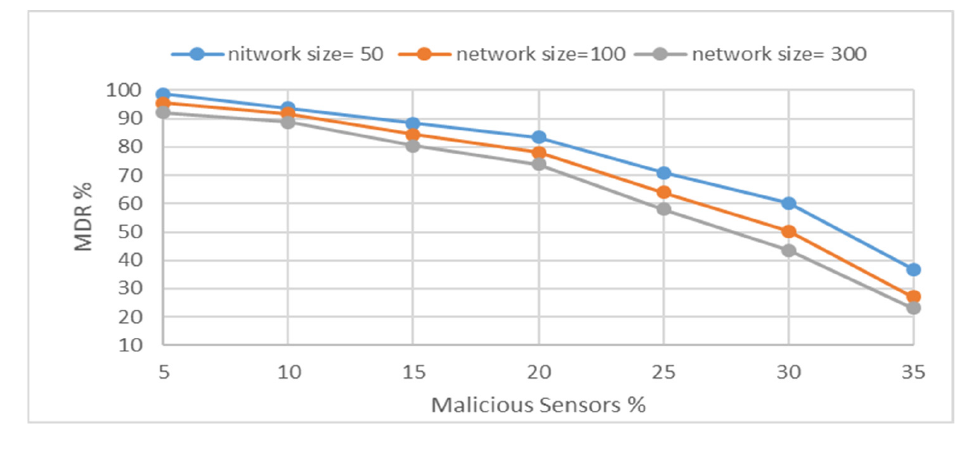
Figure 3. MDR vs. % malicious sensors in WSNs.